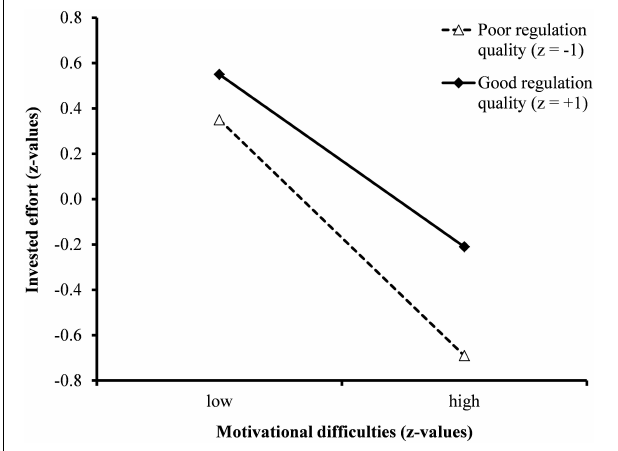
FIGURE 1 | Moderating effect of regulation quality on the connection between motivational difficulties and invested effort (depicted are predicted values).